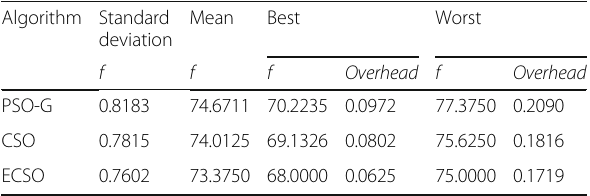
Table 6 Comparison of the optimization solutions with three algorithms for solving K64 Algorithm Standard Mean deviation